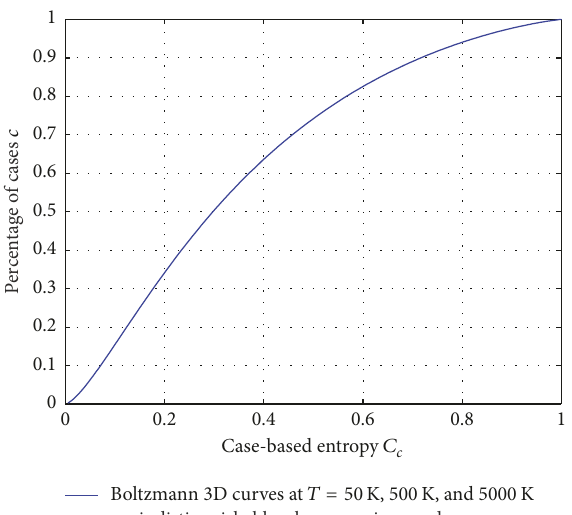
Figure 2: 𝐶 𝑐 versus 𝑐 for Boltzmann 3D superimposed at three different temperatures: 𝑇 = 50 K, 500 K, and 5000 K.